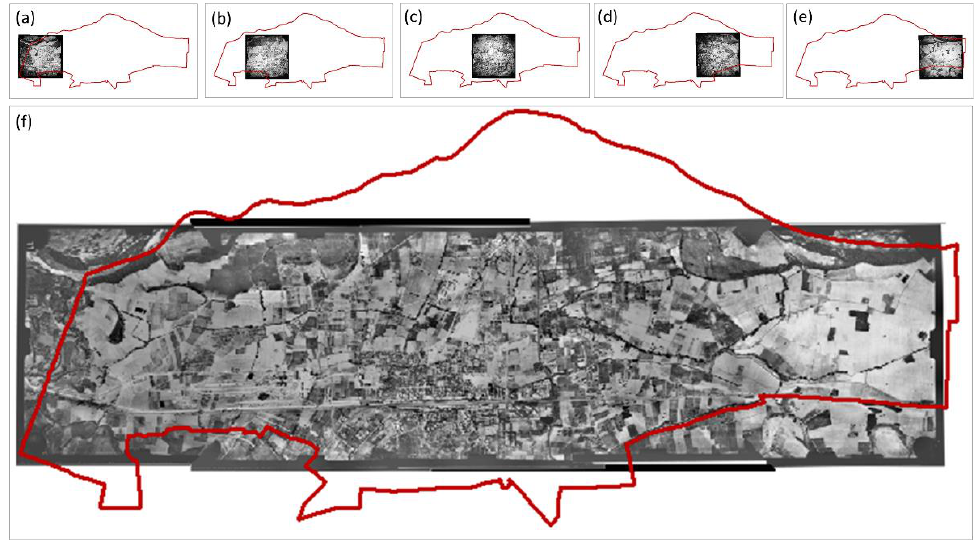
Figure 9. ( a – e ) Aerial photographs from 1952 covering parts of Stamboliyski and ( f ) mosaicked 1952 Stamboliyski aerial photograph. Red vector illustrates the boundaries of the Stamboliyski town.